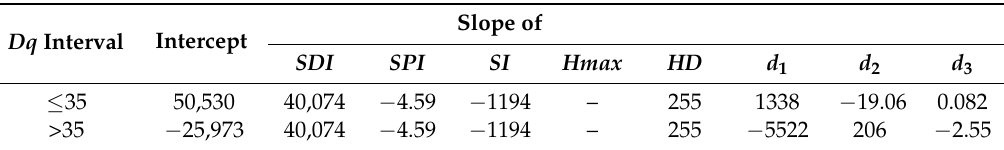
Table A3. The parameters of the approximation to the deterministic part of the BSFI-based model (see Section 2.3 and Equation (A3)) that substitutes s ( Dq ) by two polynomials; the intercept implies that of the polynomial approximation and thus depends on the interval of Dq